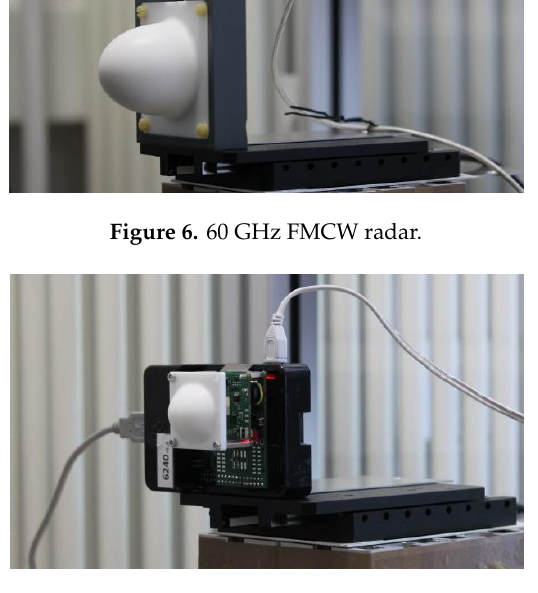
Figure 7. 122 GHz FMCW radar .